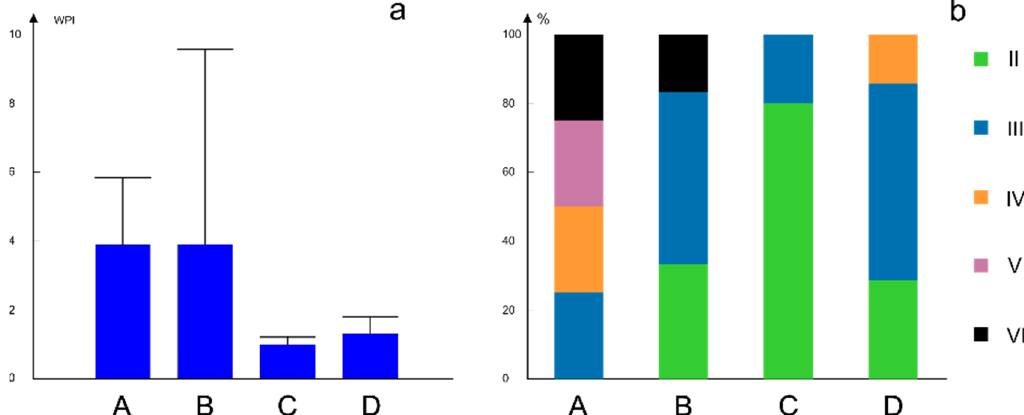
Figure 8. ( a ) Variation of WPI values in four types of chironomid assemblages; bars represent average values while lines denote the variance of WPI values within each group of assemblages. ( b ) Distribution of four chironomid assemblage types in different classes of water quality calculated through WPI; water quality class based on WPI is in Roman numerals II-VI, from very pure to heavily impure (see Table 1); four assemblage types are in capital letters A, B, C, D coloured as indicated. Table 4. Correlations between WBT and WPI with environmental variables. WPI WBT